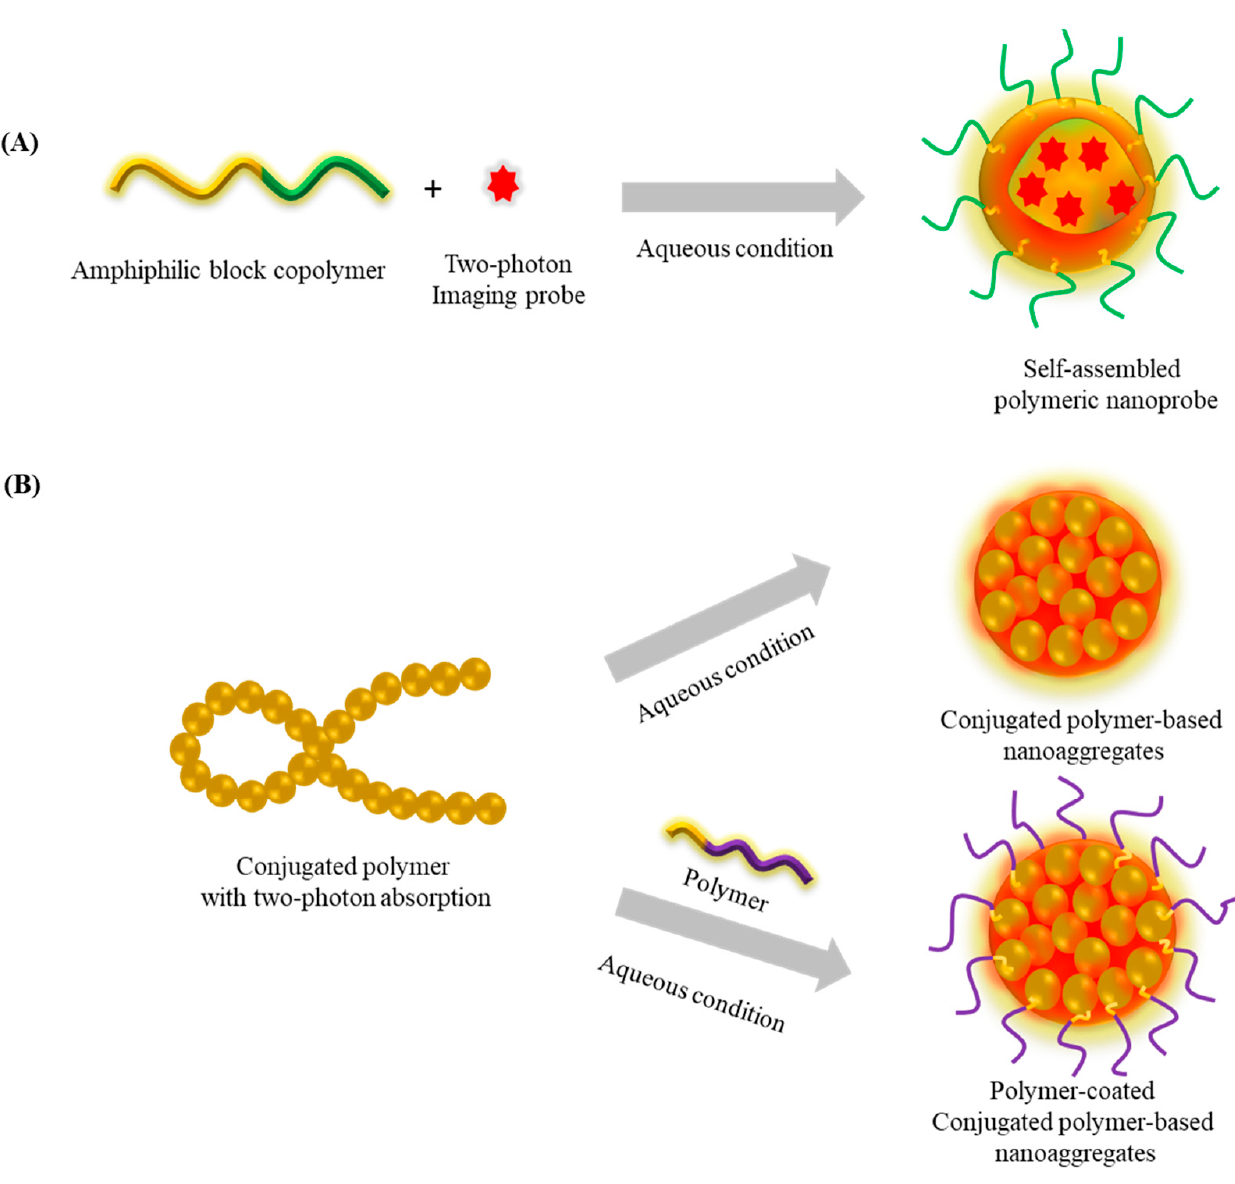
Figure 2. Schematic illustration of ( A ) two-photon imaging probe encapsulated polymeric nanopar- ticles and ( B ) conjugated polymer-based nanoaggregates with or without polymer coating for two- photon imaging.